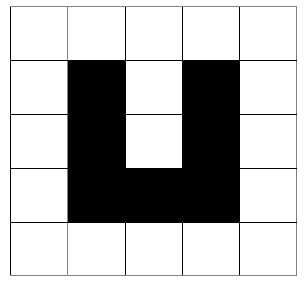
Figure 4. Deadlock phenomenon.